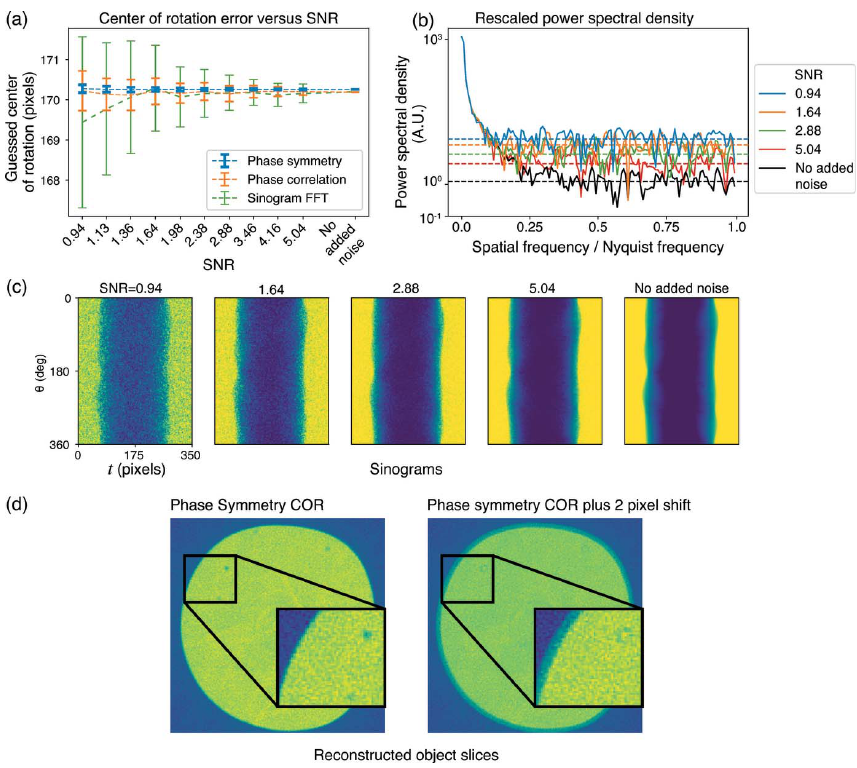
Figure 4 The effect of varying SNR on algorithms for finding the center of rotation (COR) for the tomo_00064 data set. In ( a ), we show the COR along the ^ tt -axis as determined by three methods (phase symmetry, phase correlation, and sinogram FFT) for real data with simulated noise. Center finding was repeated for 100 instances of simulated Poisson noise for each value of (cid:3) nn and resulting SNR as summarized in Table 1. From these 100 instances, the mean value of the center of rotation, as well as the standard deviation of the results, are shown for each SNR value. In ( b ), the power spectral density for the reflection image pair is shown for a smaller subset of SNR values, with all curves normalized to the same power at zero spatial frequency; as expected from Fig. 3( d ), the lowest spatial frequencies are least affected by noise. The sinograms versus SNR are shown in ( c ). In ( d ), a reconstruction of the sinogram is done for the COR as determined by the phase symmetry method (left), and also for a 2 pixel offset in the COR (right); as can be seen, the image on the left shows no ring or tuning-fork artifacts, while the image on the right shows ring artifacts as expected for this 360 (cid:2) data set.